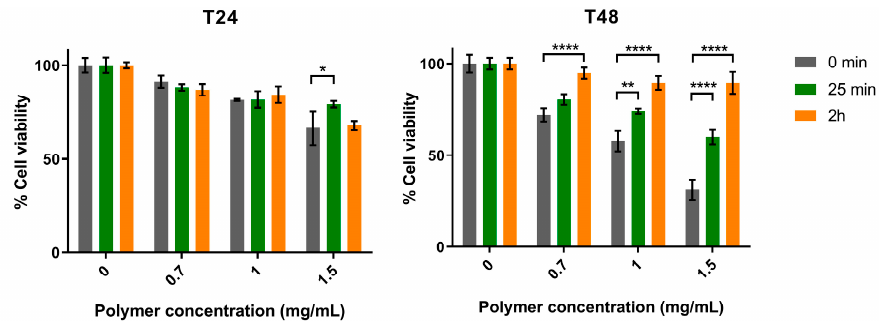
Figure 2. Effect of the Synechocystis ∆ sigF polymer (0 min), and its variants obtained after hydrolysis with TFA for 25 min or 2 h, on the viability of human melanoma (Mewo) cell line evaluated with the PrestoBlue TM viability assay. Cells were treated with 0.7, 1 or 1.5 mg/mL of polymer for 24 or 48 h (T24 and T48, respectively). Cells were also treated with polymer vehicle as control, showing no differences to Blank (data not shown) . Results are expressed in relation to Blank and are represented as mean ± STD of three independent experiments (* p < 0.05, ** p < 0.01 and **** p < 0.0001).